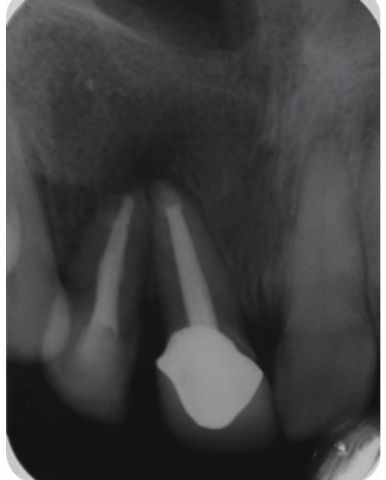
Figure 47: 24-month followup IOPA radiograph.